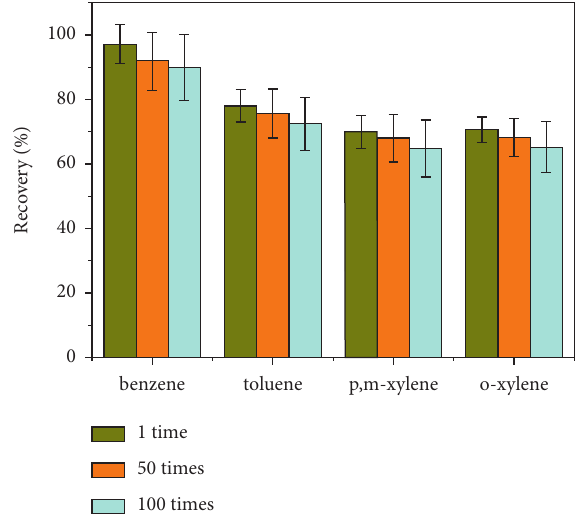
Figure 4: Recyclability of the UiO-66 tube. Table 3: Comparison of BTX concentrations in indoor air samples analyzed with different sorbent tubes ( μ g m − 3 ). Sorbent